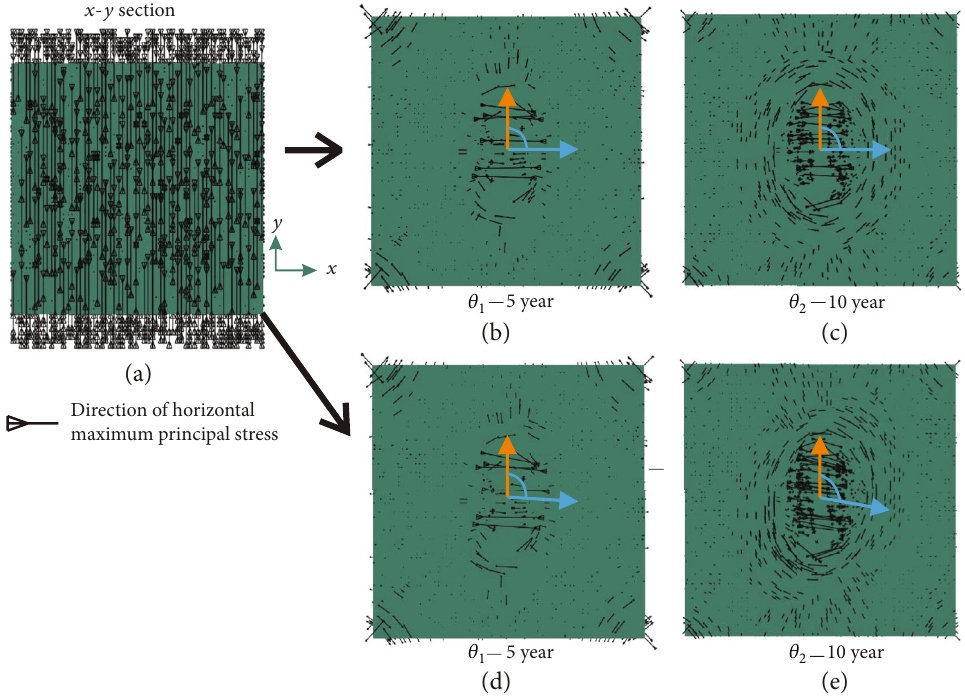
Figure 13: (a) presents the direction of the maximum principal stress on the x - y section in the initial state. (b) and (c) present the direction of the maximum horizontal principal stress after 5 years and 10 years of production without considering natural fractures. (d) and (e) present the direction of the maximum horizontal principal stress after 5 years and 10 years of production considering the in fl uence of natural